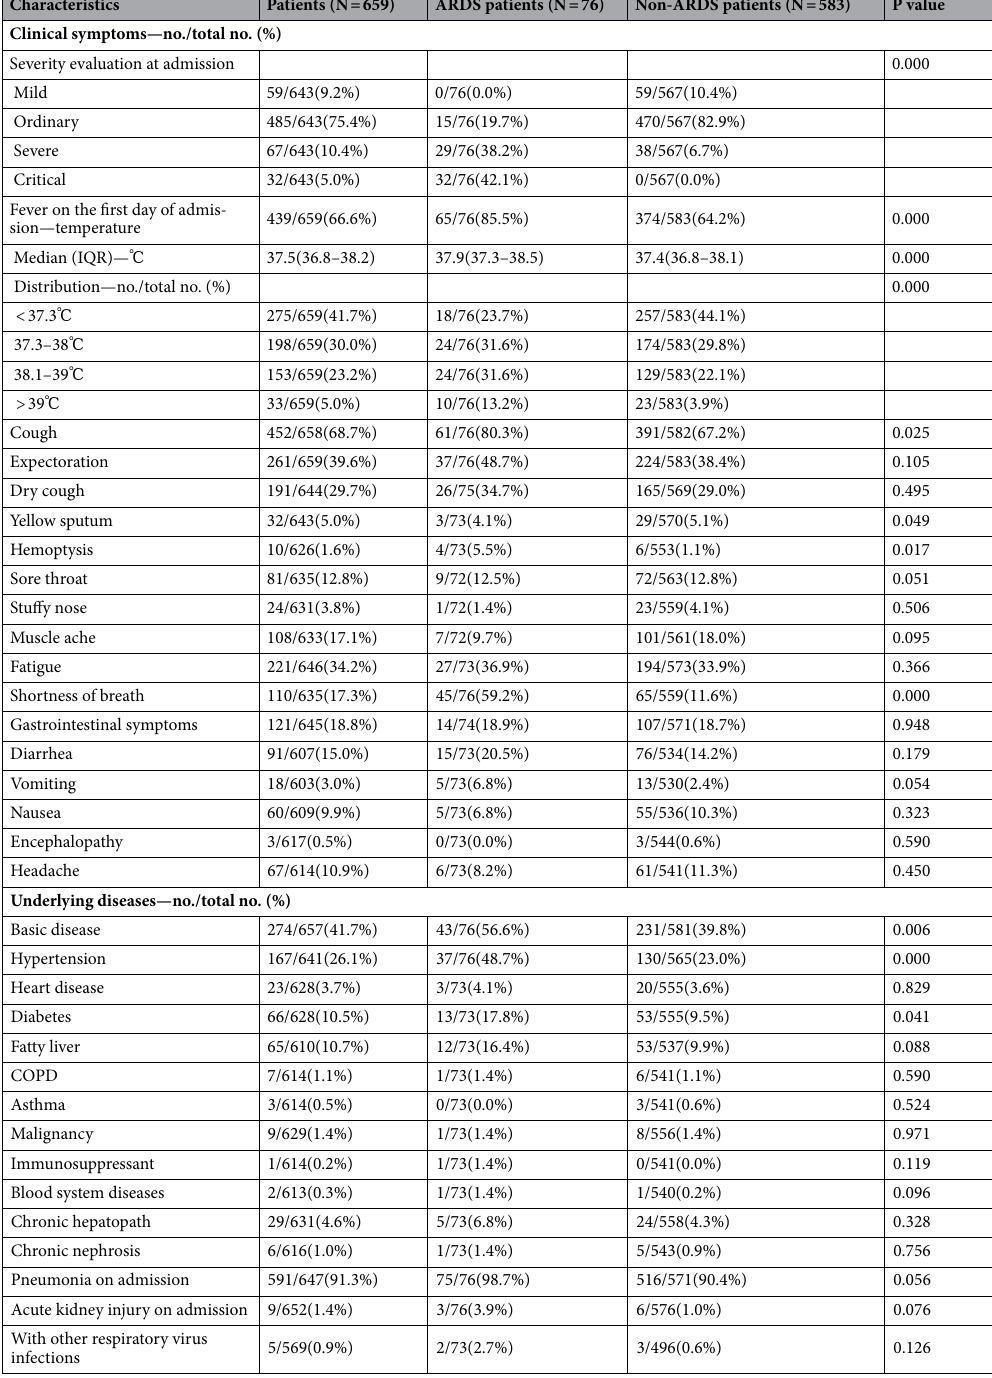
Table 2. clinical characteristics and underlying diseases. COPD, chronic obstructive pulmonary disease; no., number. Data are presented as medians (interquartile ranges, IQR) and no./total no.